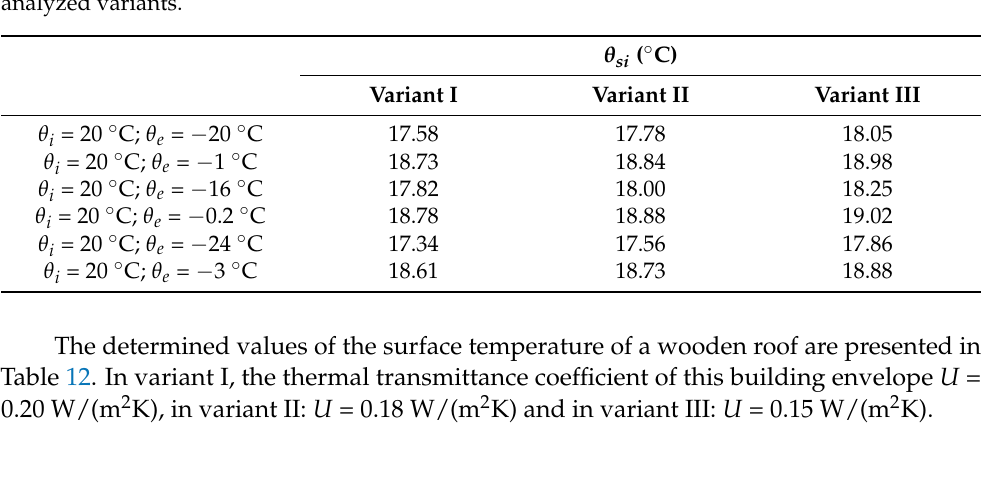
Table 11. The results of the simulation of the surface temperature of the external wall in three analyzed variants.